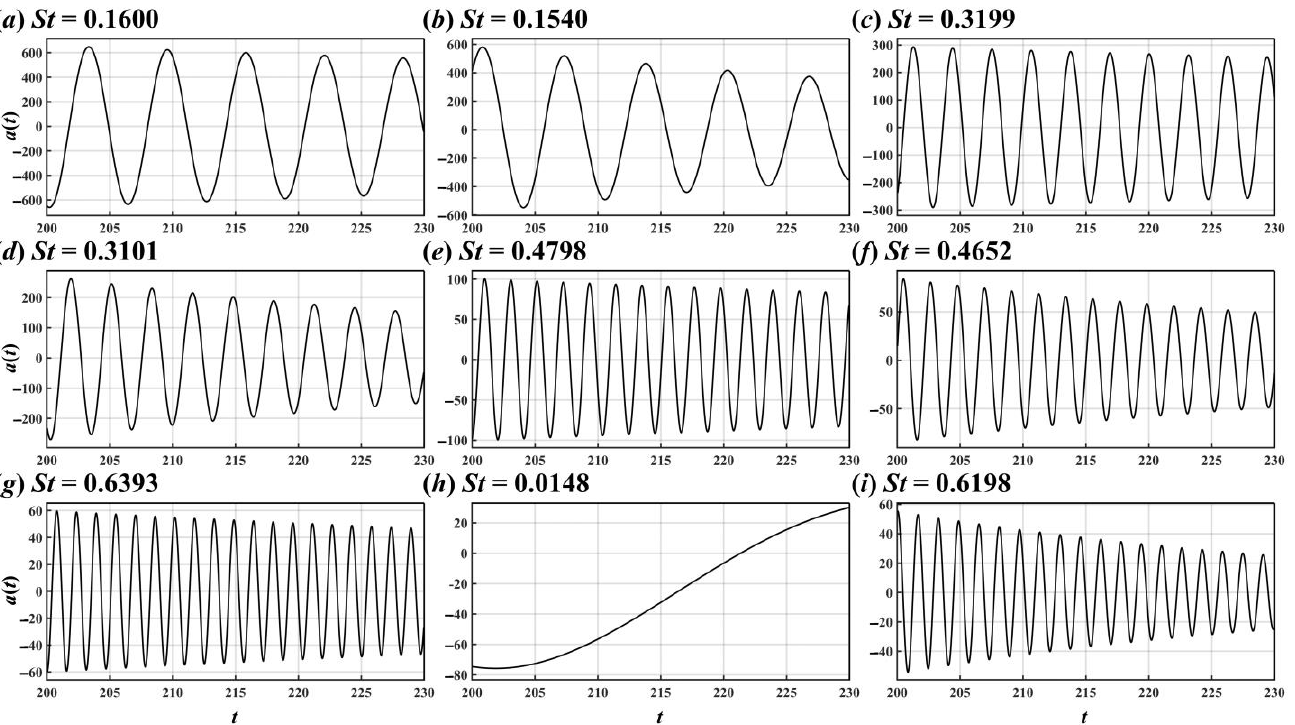
Figure 33. Time coefficients of the St = 0.1600 ( a ), 0.1540 ( b ), 0.3199 ( c ), 0.3101 ( d ), 0.4798 ( e ), 0.4652 ( f ), 0.6393 ( g ), 0.0148 ( h ), and 0.6198 ( i ) DMD modes for the flow around the two crossing cylinders in 90° arrangement.